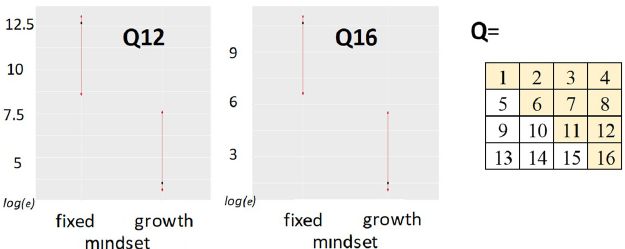
Figure 6. Illustrations of upper diagonal elements of Q separated by fixed and growth mindset conditions. The arrows represent 95% confidence intervals.